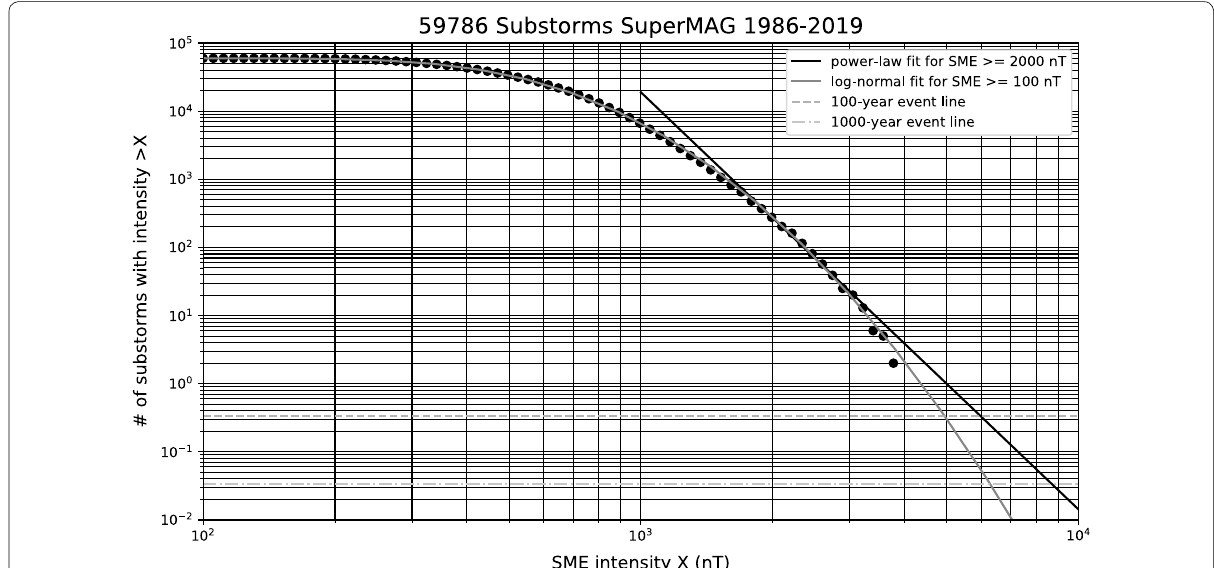
Fig. 5 Cumulative distribution function of ~ 6 10 4 substorms identified by SuperMAG for time interval 1986 to 2019. The data points are displayed × at even intervals in logarithmic scale. Log-normal and power-law fits are shown by thick and thin solid curves, respectively. The best fitted parameters are α 7.1, μ 2.7, and σ = = =